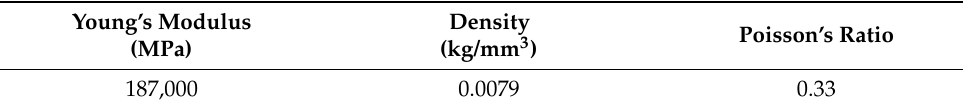
Table 1. Linear isotropic material properties.